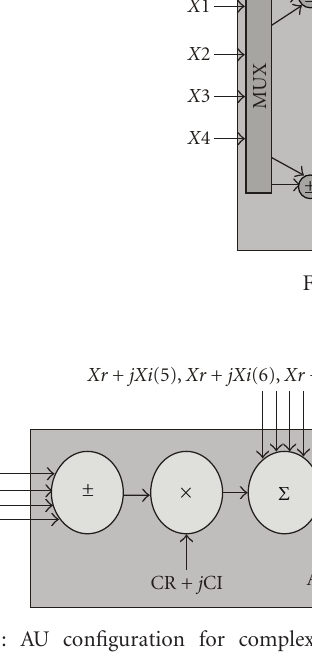
Figure 13: AU configuration for real multiplication-accumulation.